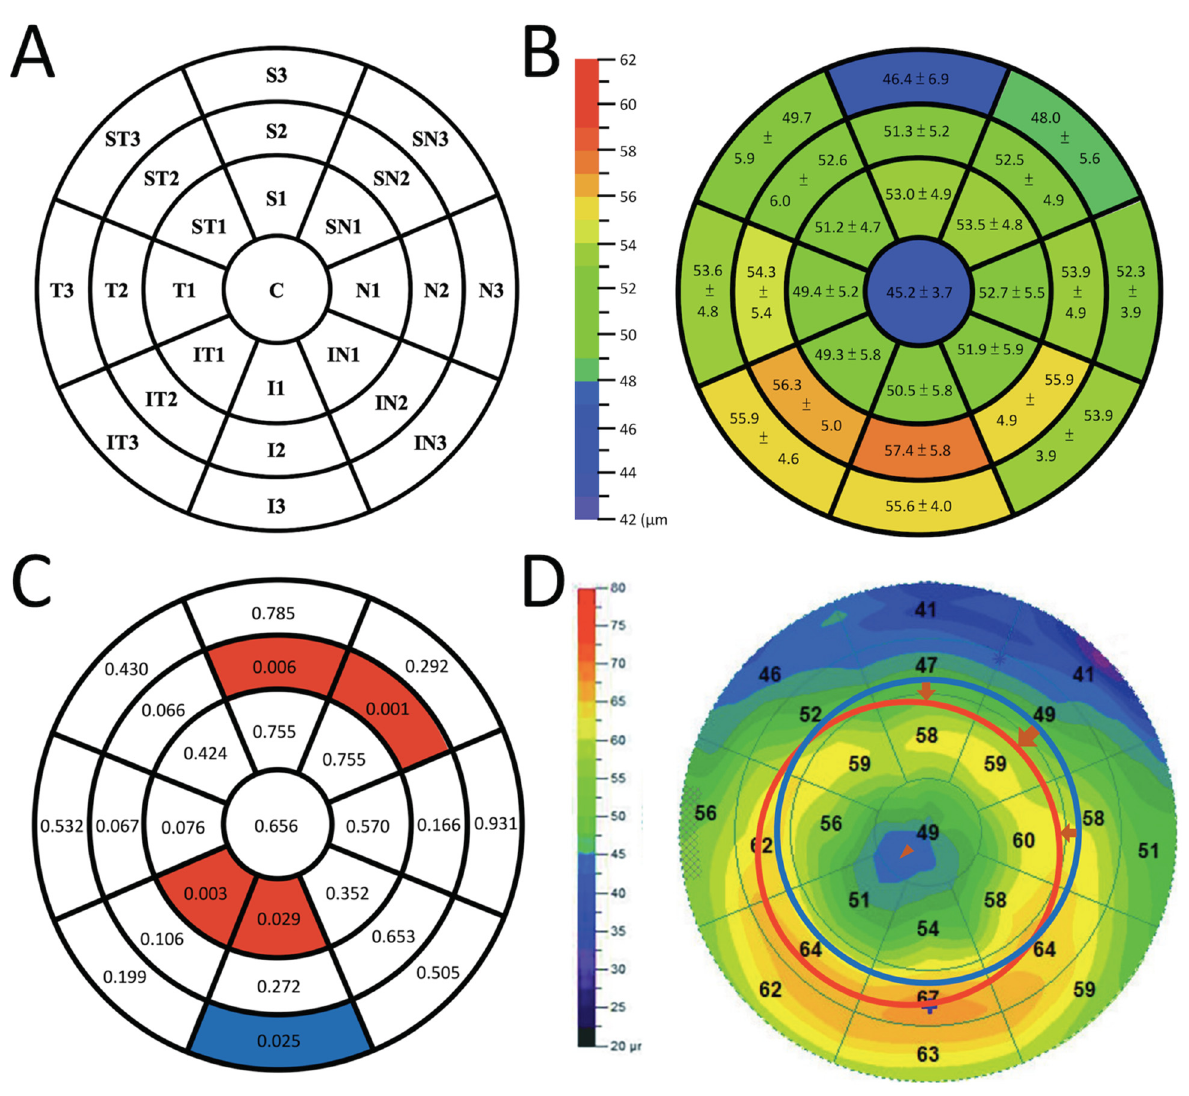
Figure 1. The illustrations regarding the wide epithelial thickness map (ETM) in the current study. ( A ) A 9 mm-diameter wide ETM and the nomenclature of each sector/zone (right eye). ( B ) The mean epithelial thickness (± standard deviation) of each sector/zone on the wide ETM. ( C ) Associations between annual changes in axial length and corneal epithelial thicknesses of the wide ETM sectors, presented with p -values calculated using generalized estimating equations. Associations in sectors IT1, I1, SN2, and S2 were significant with positive β coefficients (red sectors), while sector I3 was significant with a negative β coefficient (blue sectors). ( D ) Demonstration of the pupil centered wide ETM from a patient with inferotemporal shift and tilting of orthokeratology. The midperipheral steepening moves inferotemporally (red circle) from its centered location (blue circle), and the central treatment zone also moves inferotemporally (arrowhead).